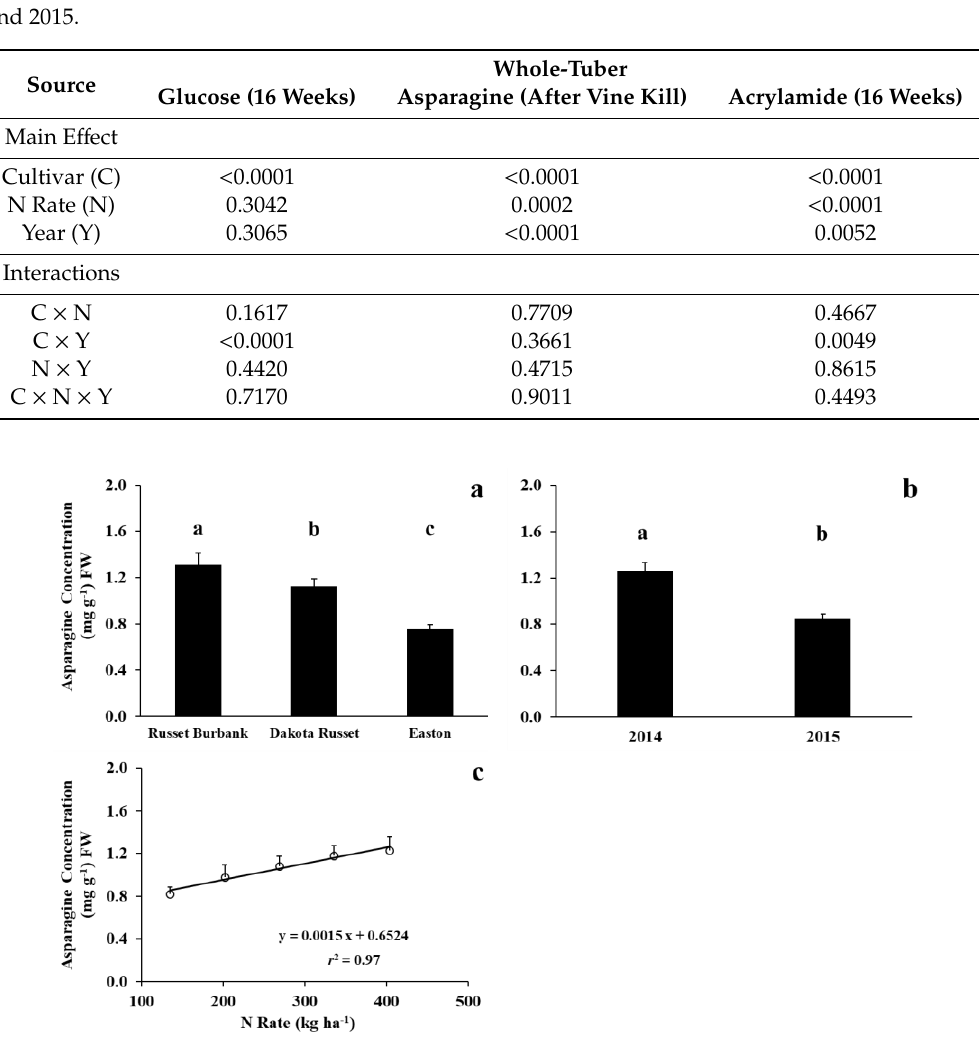
Figure 4. Main effects of cultivar ( a ), year ( b ), and N rate ( c ) on whole-tuber asparagine concentrations at 16-week storage (Means were separated at the 5% level, with the same letter above the bar indicating no significant difference.).